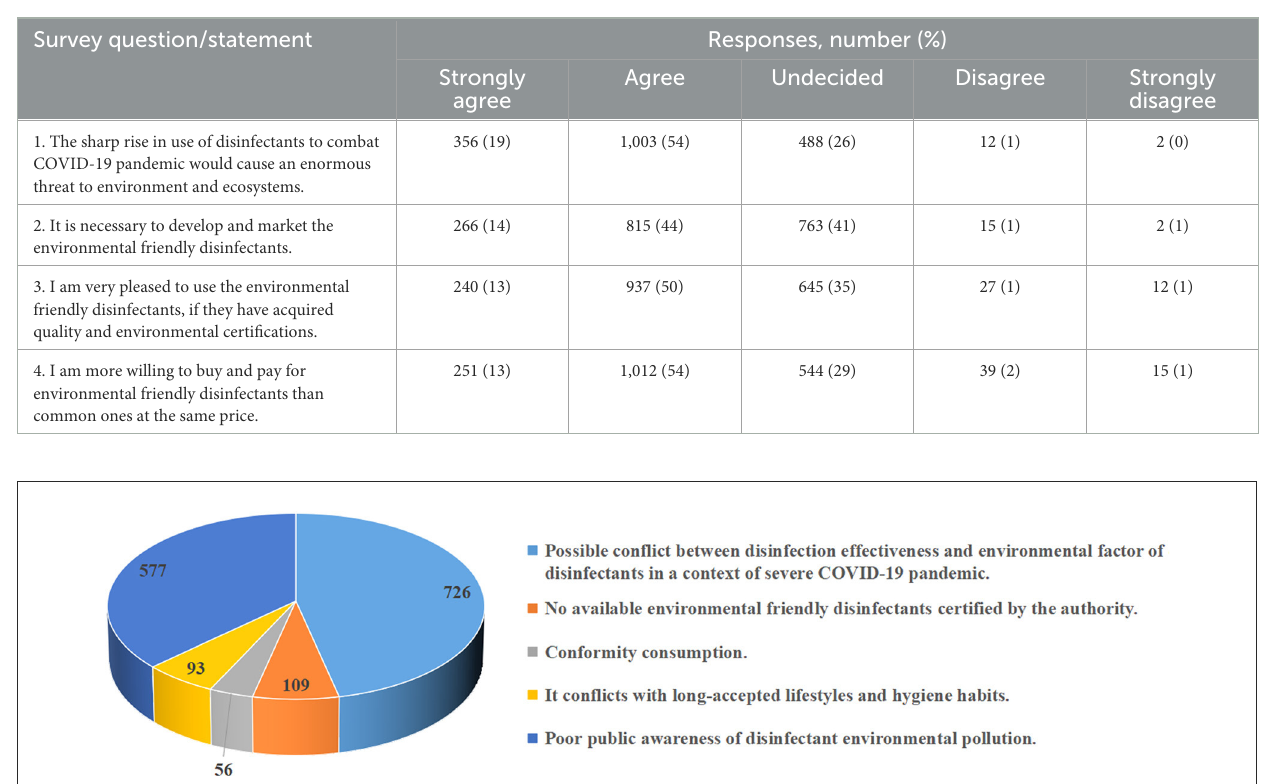
TABLE 3 Respondents’ attitudes toward environmental friendly disinfectants for household use in the post-pandemic period ( n = 1,861).